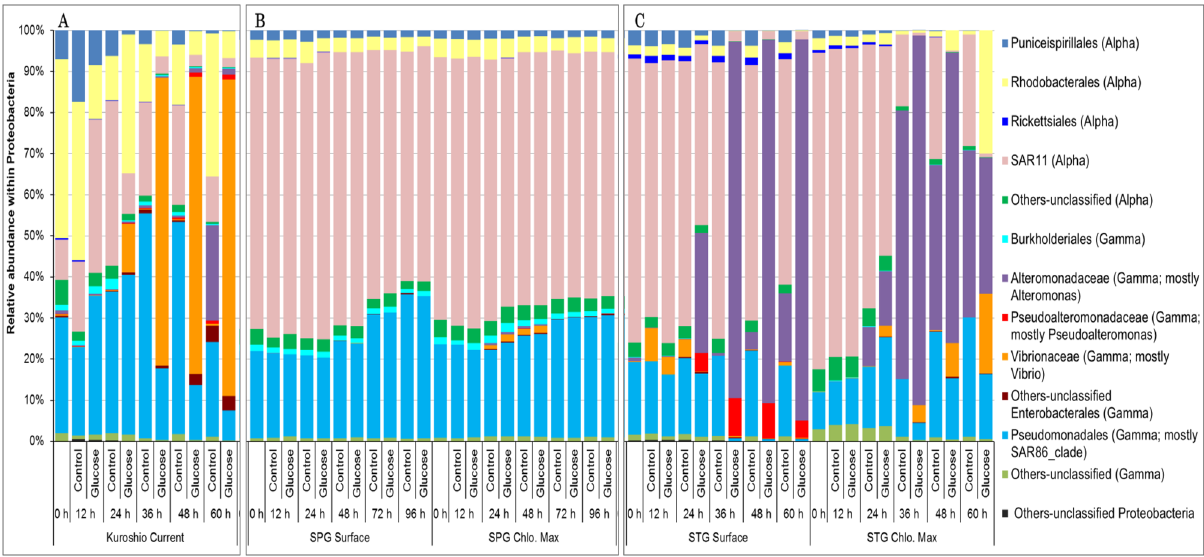
Figure 3. Changes in bacterial community composition within the phylum Proteobacteria at different time intervals in the shipboard microcosm experiments with the water collected from the ( A ) Kuroshio